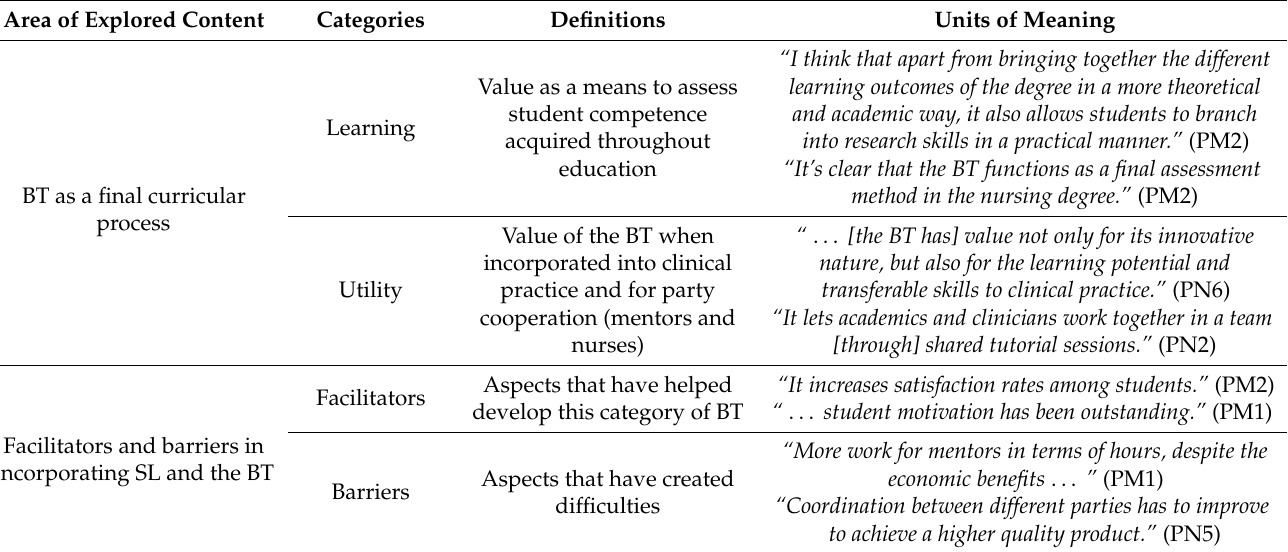
Table 6. Qualitative results matrix, Level 4 (participant nurse: PN and participant mentor: